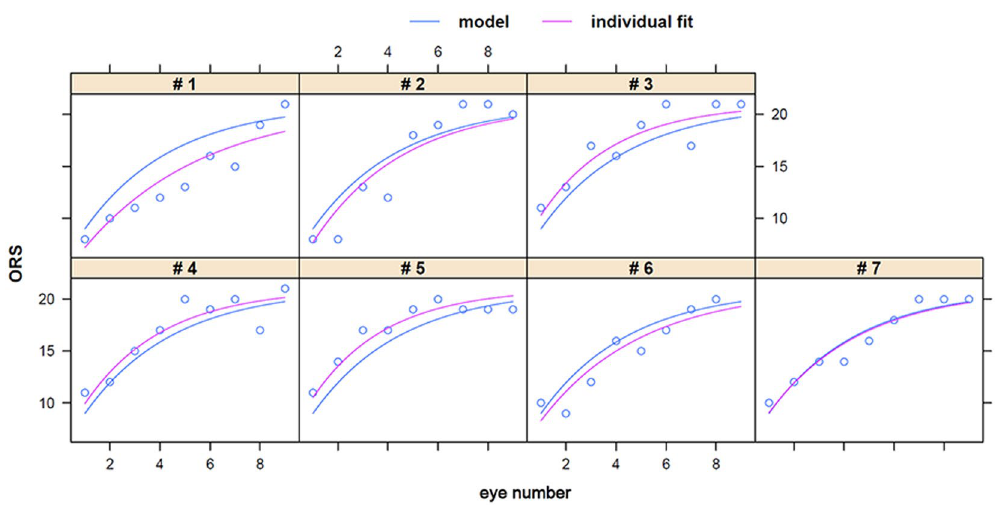
Figure 5. The Operating Room Score (ORS) had a hyperbolic shape that was very similar for all